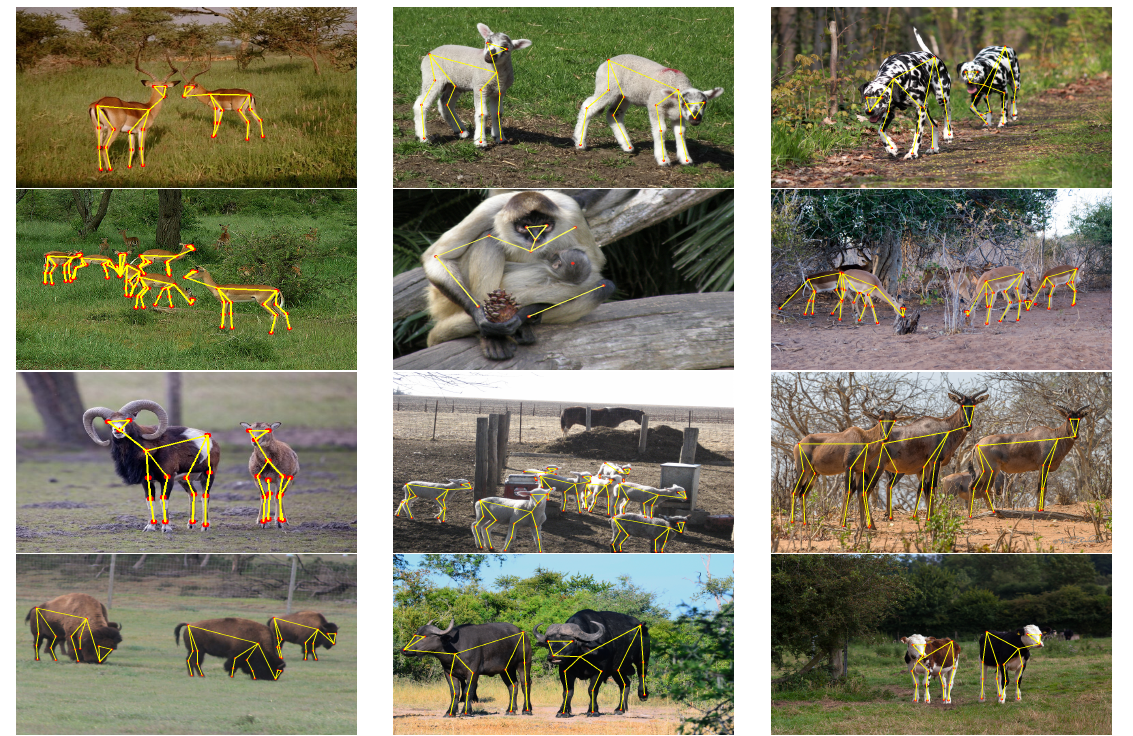
Figure 6. Example qualitative results of the AP-10K animal pose estimation test, including multiple animals and changes in